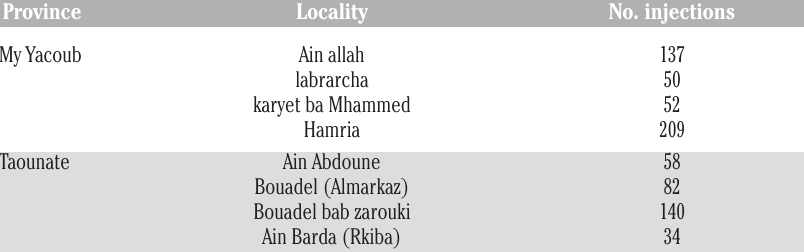
Table 1. Number of people injected by leishmanin according to